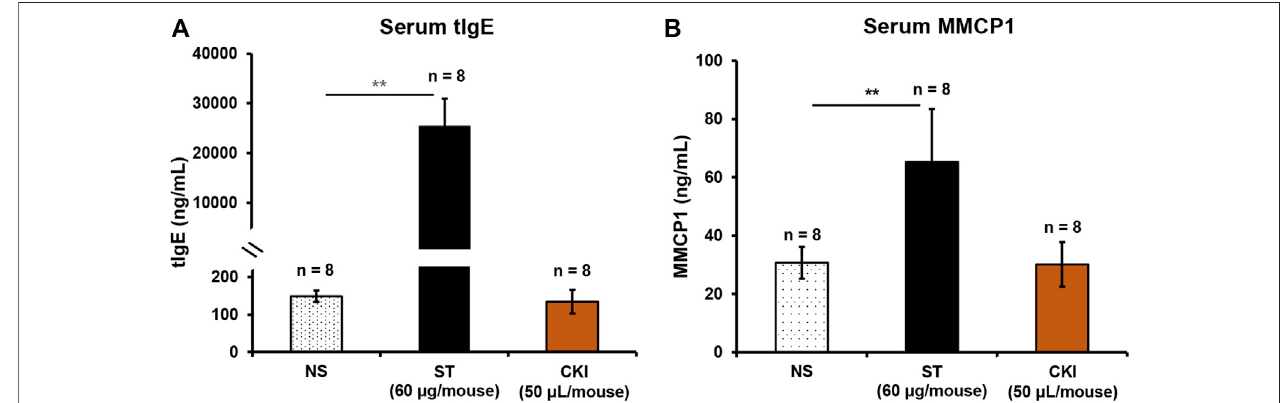
FIGURE 2 | CKI-induced IHR is independent of IgE/Fc ε RI-mediated signaling. Mice were intraperitoneally injected with ST (60 µg/mouse) or CKI (50 µl/mouse) in thepresenceofaluminumadjuvant(100µl/mouse)onceaweek.Sevendaysafterthe fi fthimmunization,serumtIgEandMMCP1weredeterminedusingtheirrespective commercial ELISA kits. ST was used as a positive control. ** p < 0.01. CKI, Compound Kushen Injection; IHR, immediate hypersensitivity reaction; MMCP1, mast cell protease 1; NS, normal saline; ST, shrimp tropomyosin; tIgE, total IgE.